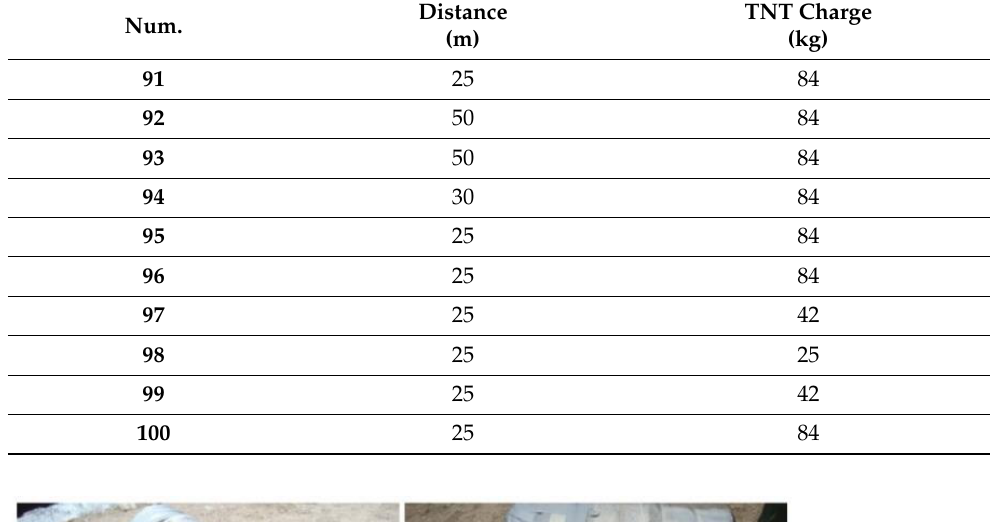
Table 5. TNT charge and distance for each test. Num.